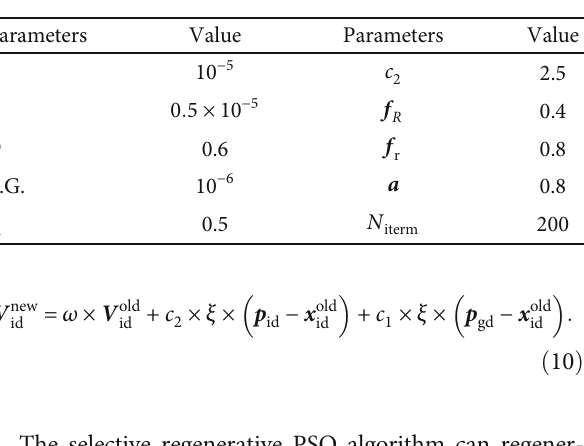
Figure 8: Numerical comparison of di ff erent Reynolds numbers for airfoil. Table 1: Absolute and relative errors of RBF. Table 2: Optimization algorithm